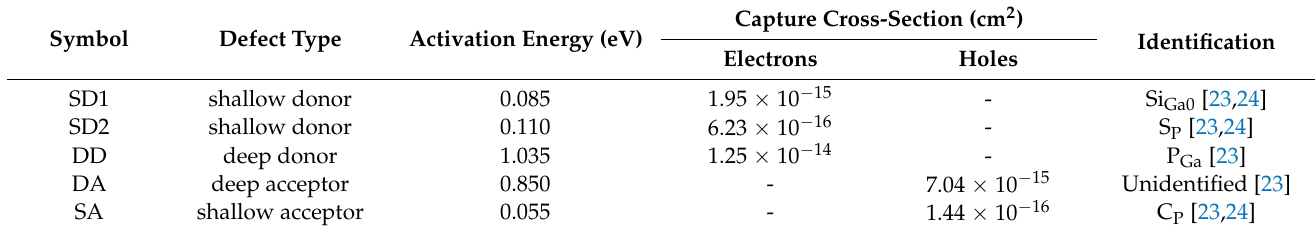
Table 1. Assumed parameters of the defect centers for the simulated